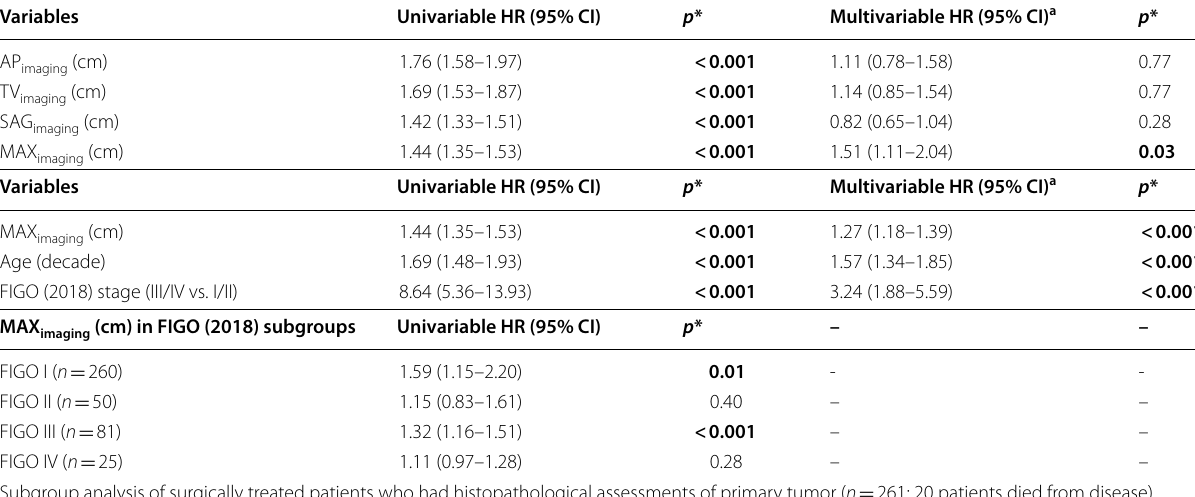
Table 4 Uni‑ and multivariable hazard ratios for MRI‑derived tumor size variables for predicting disease‑specific survival in 416 patients with uterine cervical cancer (78 patients died from